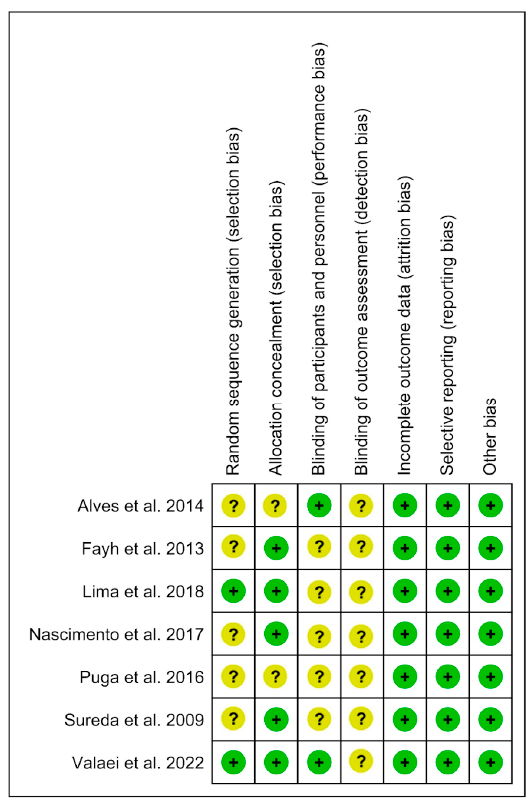
Figure 2. Risk of bias tool [12–14,16–19].